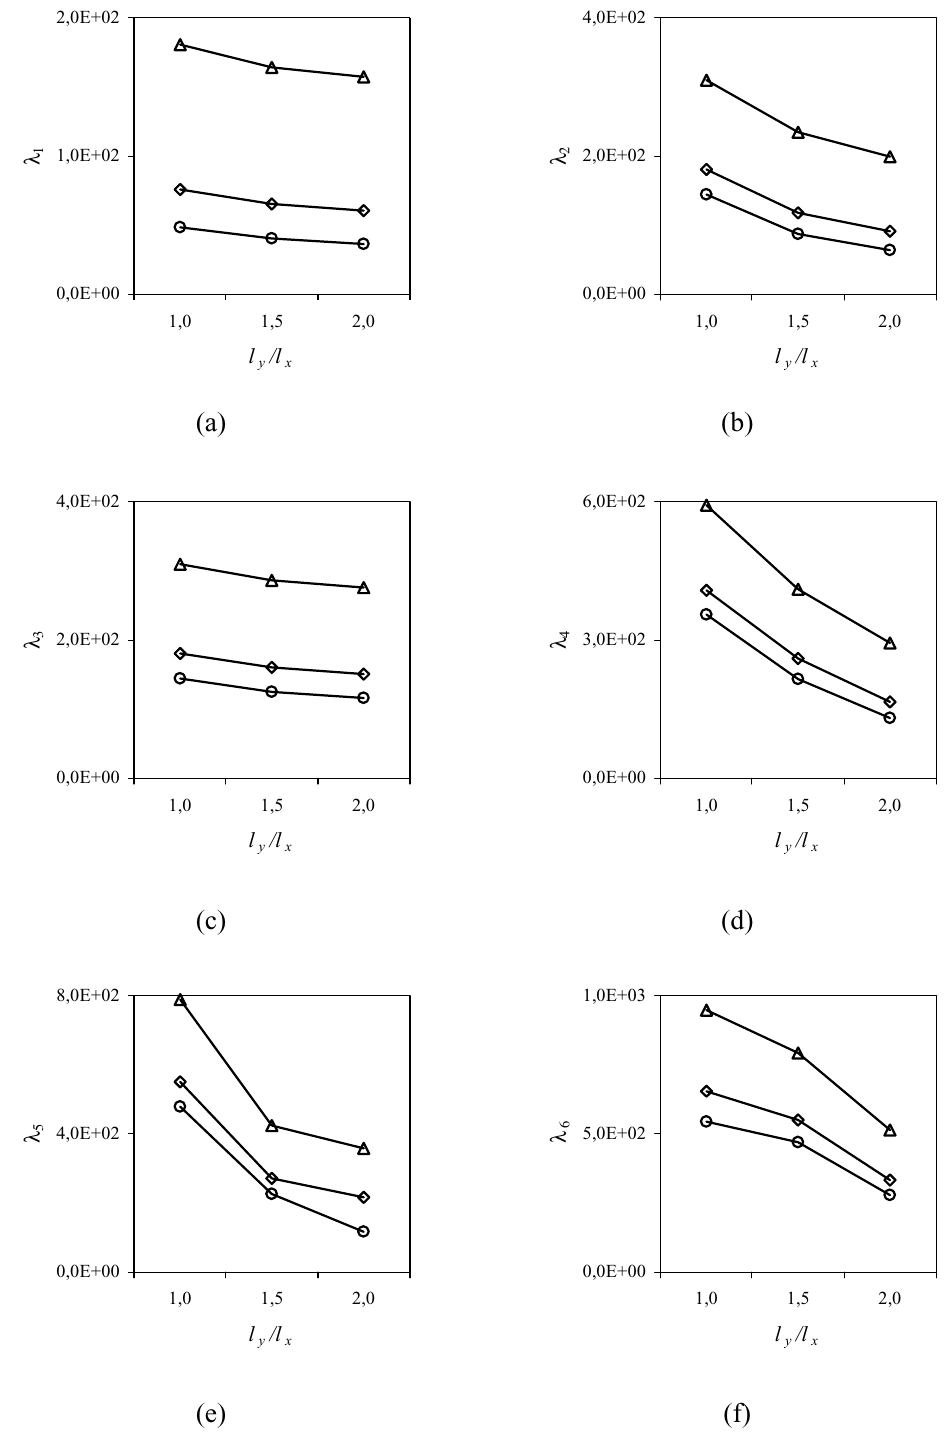
Fig. 3. The variation of the first six frequency parameters of the plate on elastic foundation with various values of l y /l x ratio and H for γ = 1 . – ∆ –, H = 5 m; – ♦ –, H = 10 m; –o–, H = 15